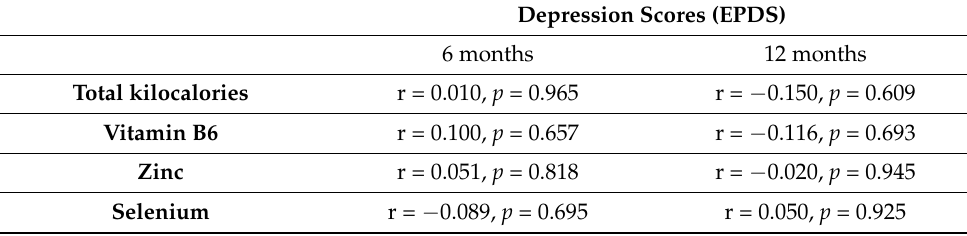
Table 2. Dietary intake and postpartum depression.